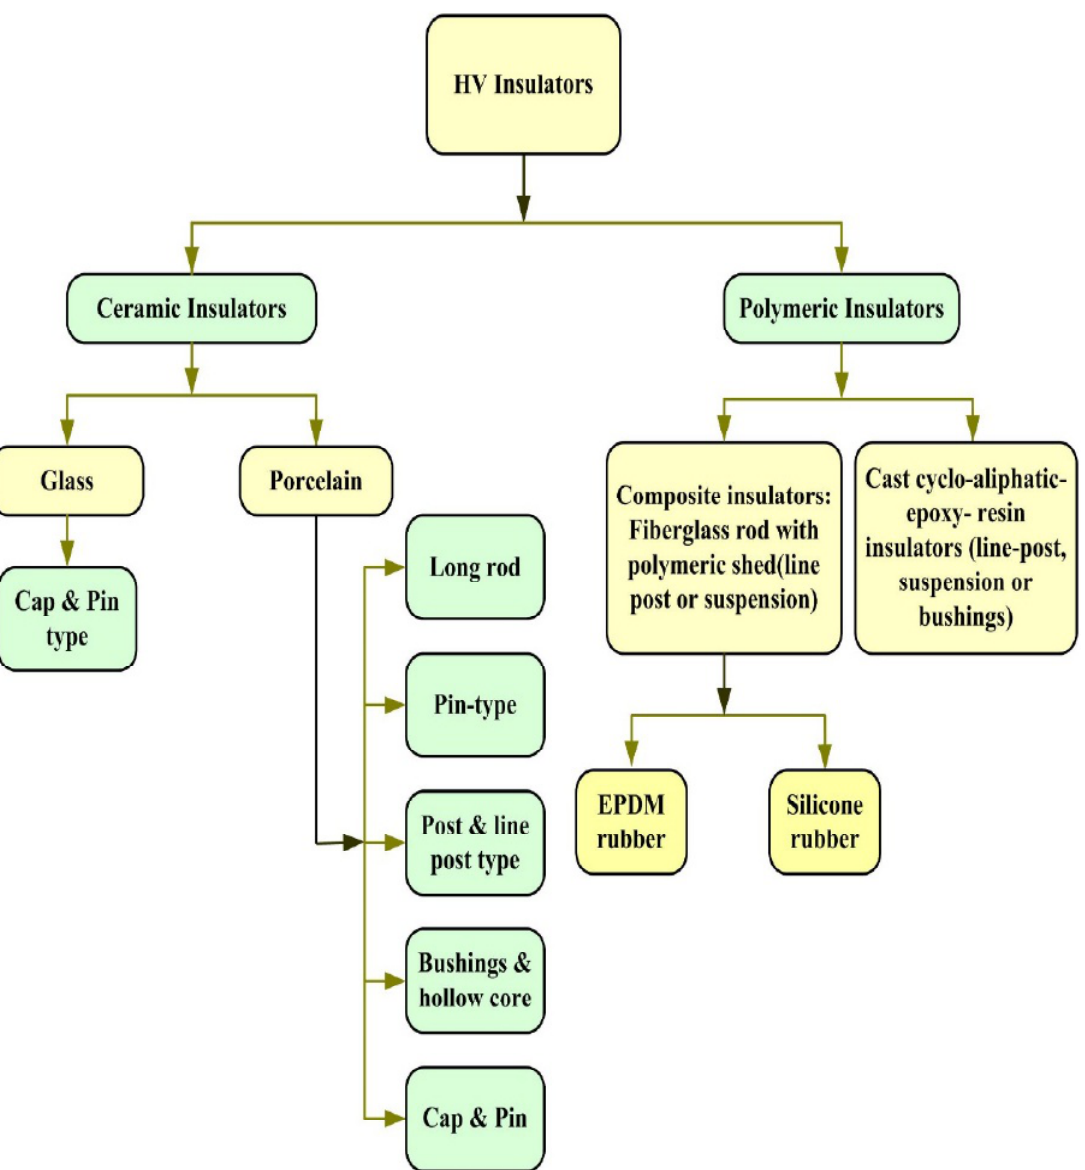
Fig. 12. Classification of HV